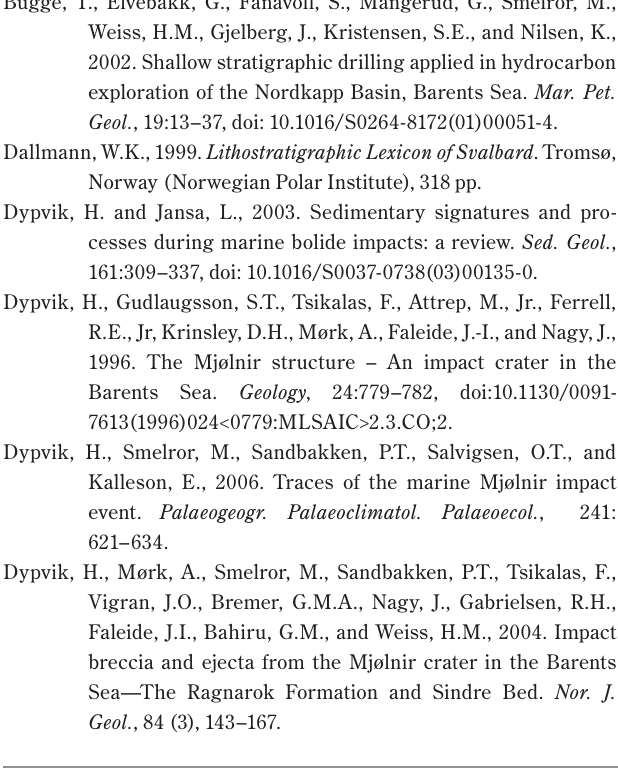
Figs. 1 and 3: Filippos Tsikalas, University of Oslo and ENI, Fig. 2: P. Claeys, A. Deutsch.P. Claeys, A.